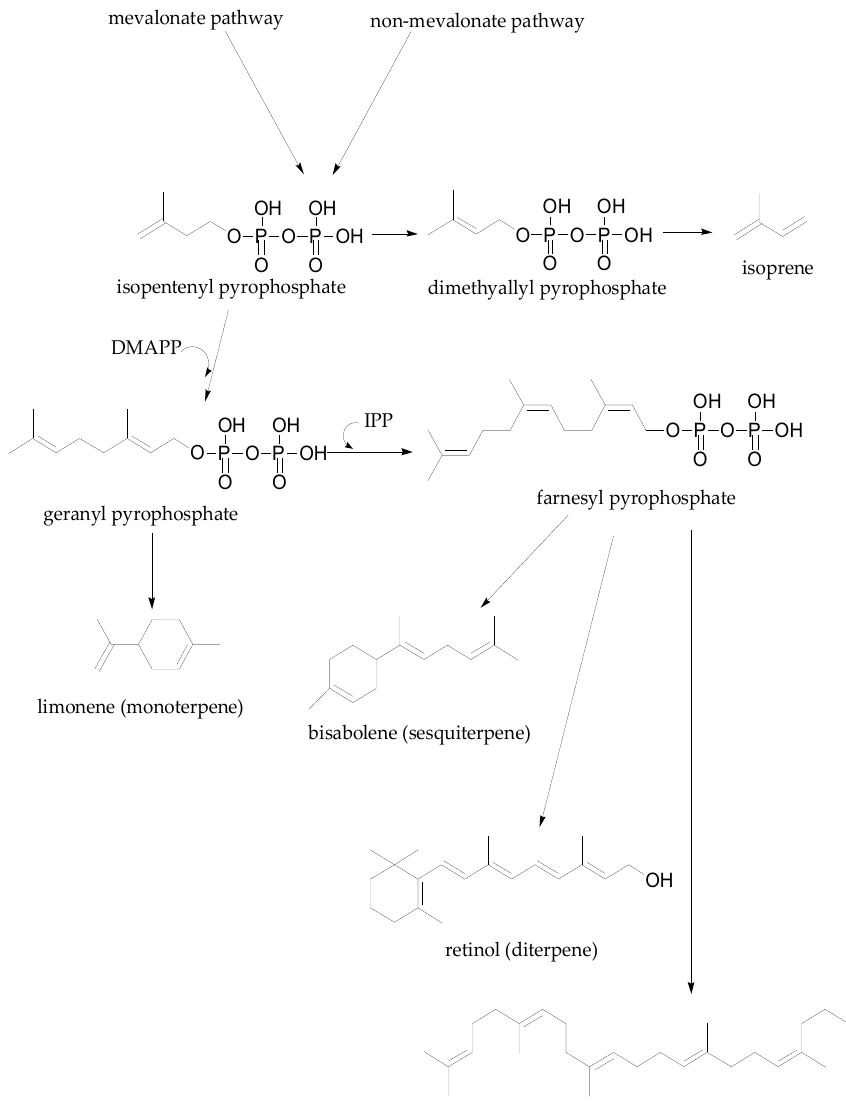
Figure 4. Biosynthesis of terpenes from isopentenyl pyrophosphate, a product of the mevalonate and non-mevalonate pathway.